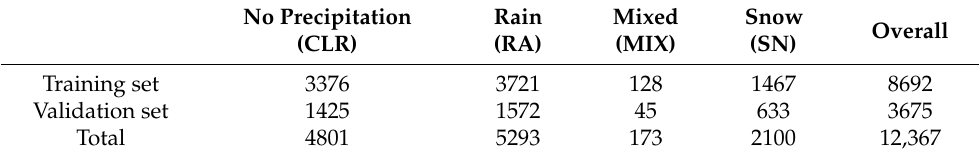
Table 2. The number of 10 min data for the training and